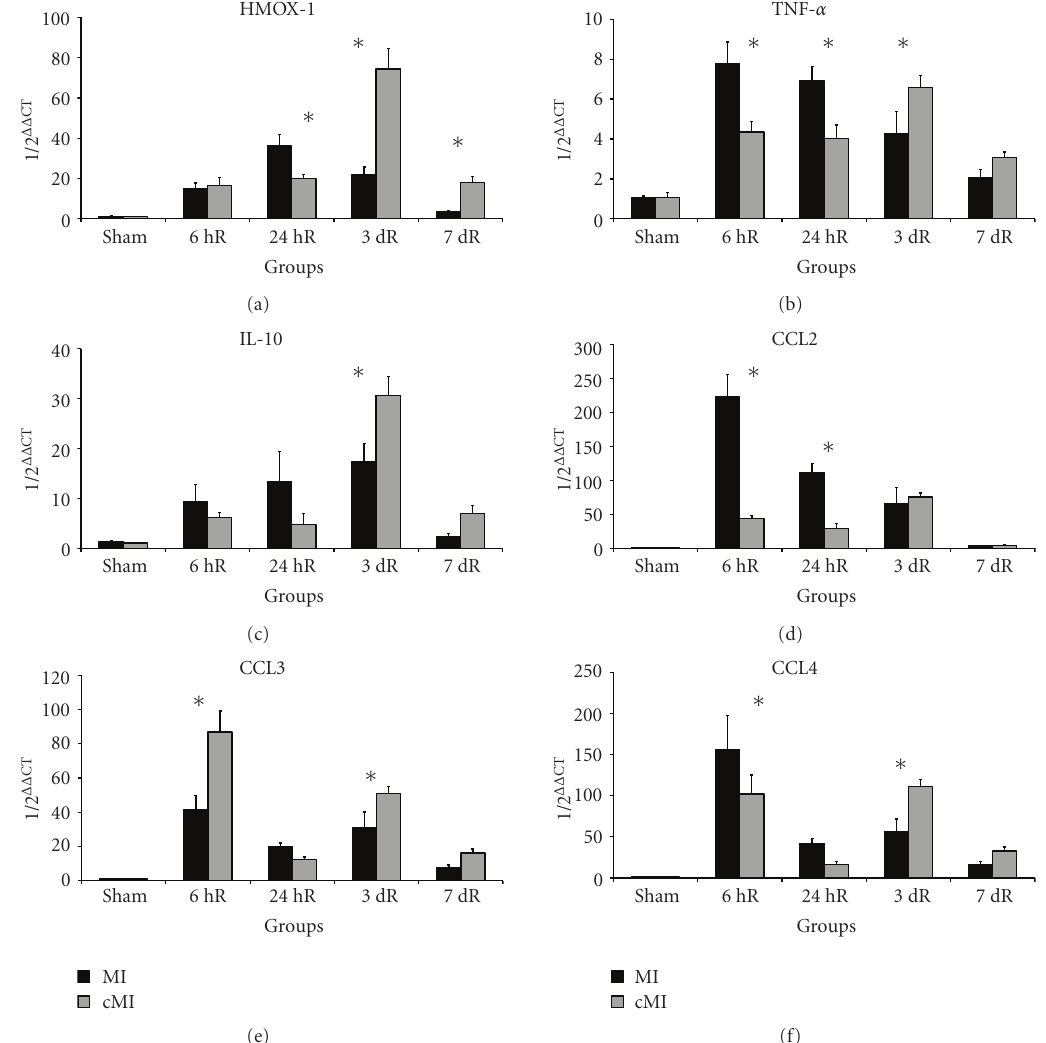
Figure 5: Expression profile of inflammatory mediators in cryoinfarction and reperfused infarction. RT-qPCR-analysis of mRNA-expression of (a) free radicals scavenger enzyme heme oxygenase 1, (b) proinflammatory cytokine TNF- α , (c) anti-inflammatory cytokine IL-10, (d) macrophage-related chemokine CCL2, (e) neutrophils-related chemokine CCL3 and (f) macrophage-related chemokine CCL4 in cryoinfarction (cMI) and reperfused infarction (MI). Data are normalized to respective shams and housekeeping gene GAPDH. ∗ P < .